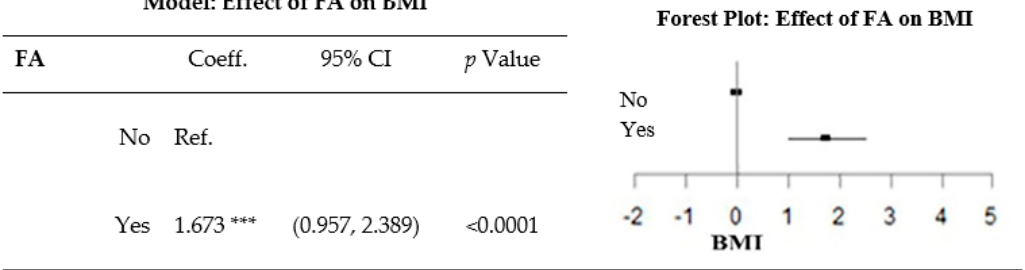
Figure 2. Effect of food addiction (FA) on the body mass index (BMI) after adjustment for sociodemographic variables. The model was obtained from a multiple linear regression, and was adjusted for sex, age group, employment status, and educational attainment. *** p -value < 0.0001. Coeff., coefficient; CI, confidence interval; Ref., reference.